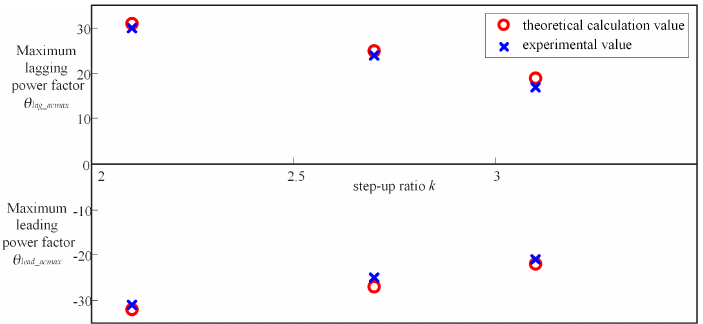
Figure 9. Waveforms of input voltage and current of the hybrid cascaded rectifier operation mode under the leading power factor. ( a ) Within the adjustable power factor angle range; ( b ) beyond the adjustable power factor angle range.